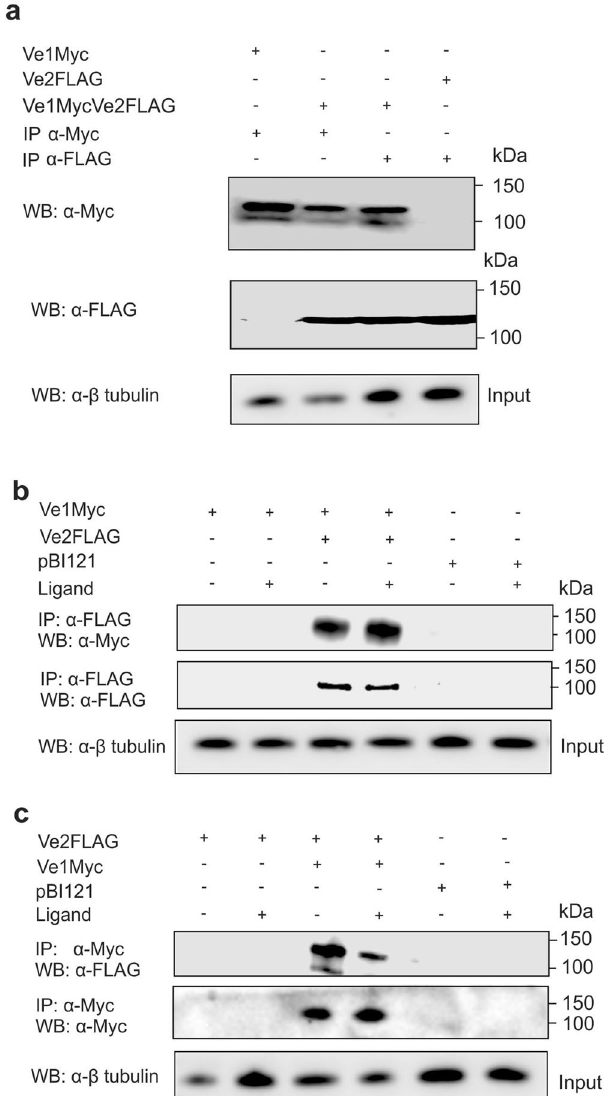
Fig. 4 Receptor translation and heteromer composition in stably transformed Arabidopsis thaliana with immunoblot input shown at the top ( + ). a Western blots of proteins extracted from Ve1Myc (left lane), Ve2FLAG (right lane), and Ve1Myc + Ve2FLAG (2 center lanes) transformed plants and probed with polyclonal anti-Myc or anti-FLAG conjugated to horseradish peroxidase. Association between the receptors was con fi rmed by co-immunoprecipitation of Ve1 and Ve2 from the Ve1 + Ve2 co-transformed plants with beads conjugated to polyclonal anti-Myc or anti-FLAG, respectively. Input was determined by dividing samples into 3 equal fractions for the top, middle, and bottom immunoblots, using β -tubulin antisera. Antibody speci fi city is indicated with the reciprocal Myc and FLAG epitopes. b Association between the receptors was further examined by combining and incubating separate plant extracts. Co-immunoprecipitation of separately extracted Ve1 and Ve2 receptors was observed following incubation with beads conjugated to polyclonal anti-FLAG in the presence ( + ) or absence (-) of the ligand, and subsequent detection with receptor epitope speci fi c Myc and FLAG antiserum but not pBI121 transformed plants. c Reciprocal con fi rmation of receptor association with co-immunoprecipitation of separately extracted Ve1 and Ve2 receptors following incubation by beads conjugated to polyclonal anti-Myc in the presence ( + ) or absence (-) of the ligand and subsequent detection with receptor epitope-speci fi c antiserum. Results con fi rm the formation of a ligand- independent Ve1Ve2 heteromer